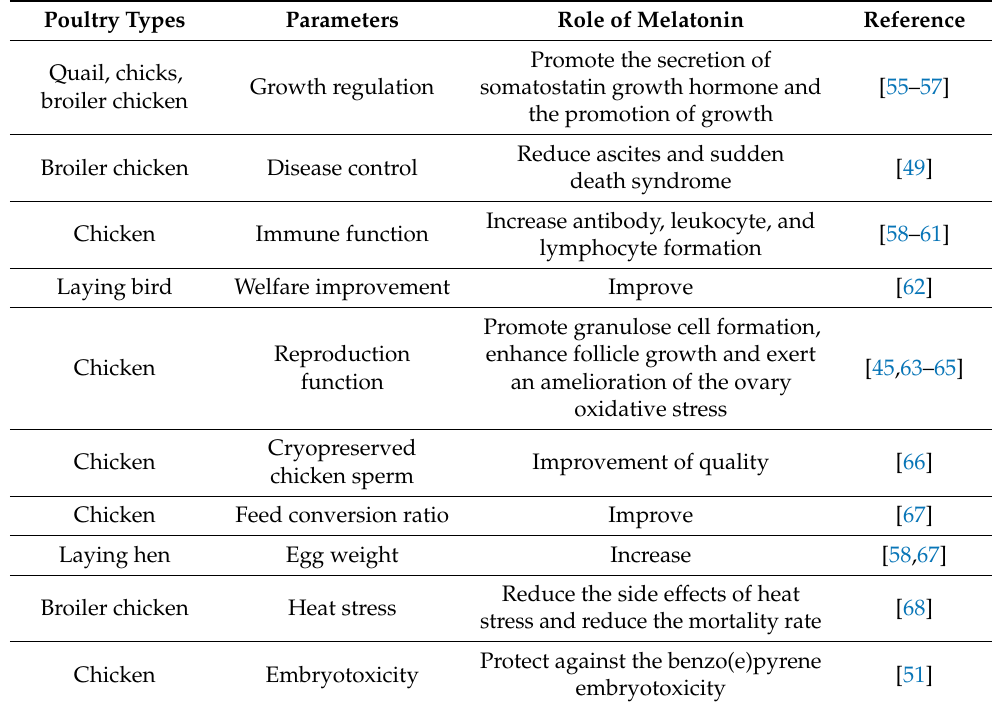
Table 2. Regulation of melatonin on poultry growth and development, animal welfare, and immune